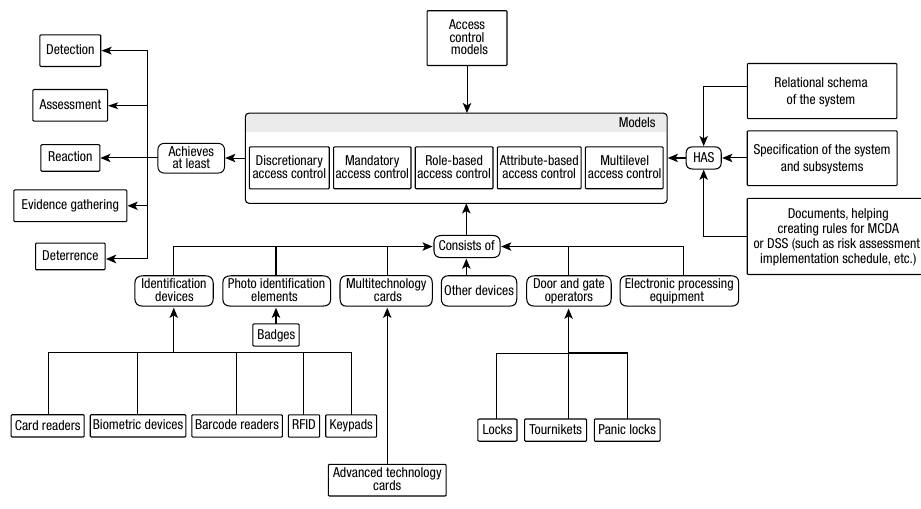
Fig. 1. Basic model of the fourth generation